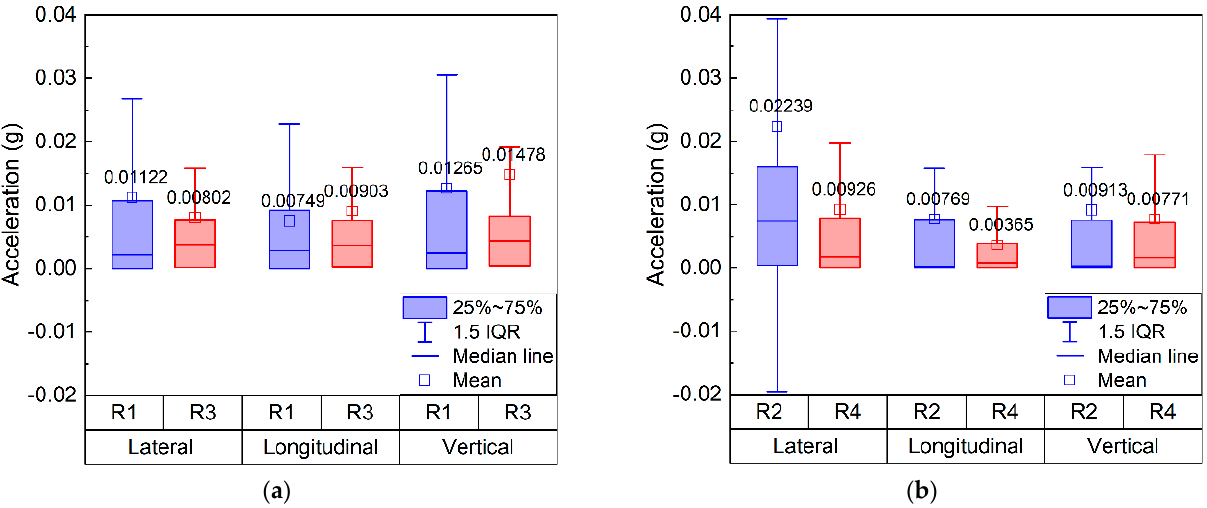
Figure 17. The box plots showing statistical distributions of 3D acceleration recorded ( a ) below the sleepers and ( b ) in-between the two adjacent sleepers at the same depth of the ballast bed prior to maintenance operations.